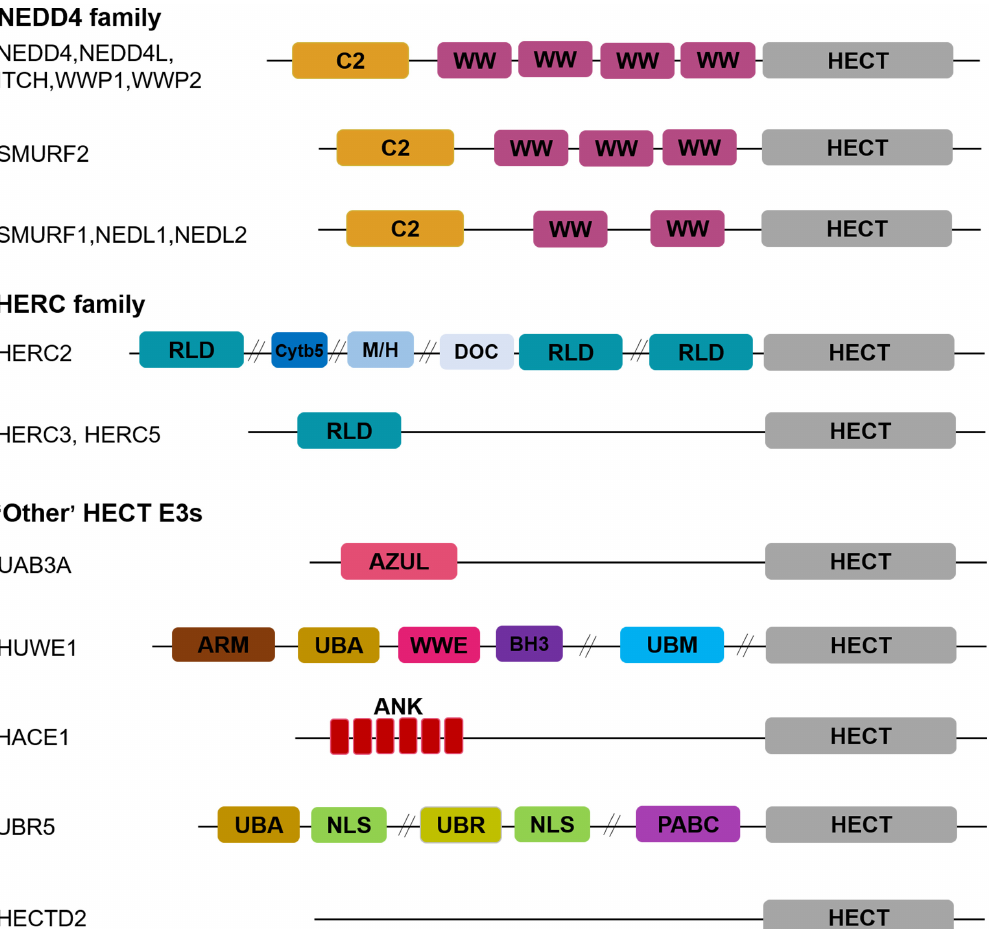
Figure 1. Structural features of the HECT E3 ligases. HECT E3 ligases are classified into three subfamilies: NEDD4, HERC, and ‘other’ HECT E3 family. The NEDD4 family is characterized by C2 and WW domains, the HERC family contains one or more RLD domains, and the ‘other’ HECT E3 family carries distinct structural domains at the N-terminus. The domain abbreviations used are as follows: C2, Calcium-dependent lipid binding domain; WW, WW domain; HECT, homologous to E6AP C-terminus; RLD, regulator of Chromosome Condensation 1 repeat-like domain; Cytb5, cytochrome b5-like heme/steroid-binding domain; M/H, MIB-HERC2 domain; DOC, APC10/DOC domain; AZUL, amino-terminal Zn-binding domain of UBE3A ligase; ARM, armadillo repeat-containing domain; UBA, ubiquitin-associated domain; WWE, WWE domain; BH3, Bcl-2 homology 3 domain; UBM, ubiquitin-binding motif; ANK, Ankyrin repeat-containing domain; NLS, nuclear localization sequence; UBR, ubiquitin-recognin box; PABC//MLLE, polyadenylate-binding protein C-terminal